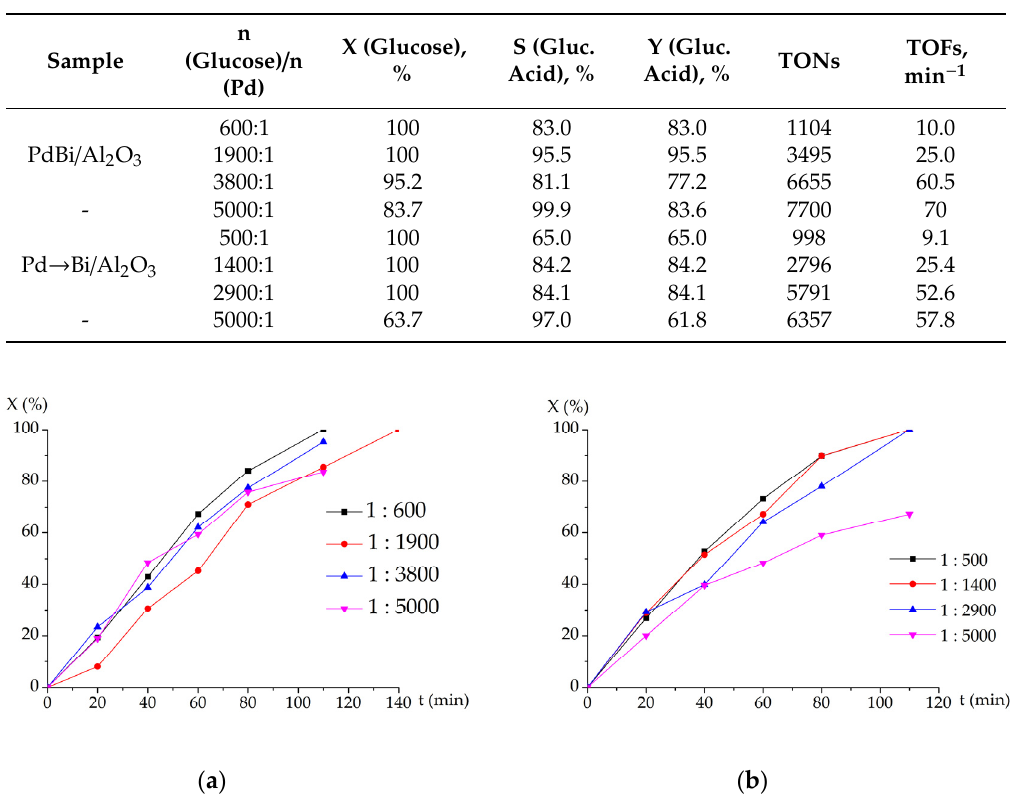
Table 5. Kinetic parameters of the reaction.